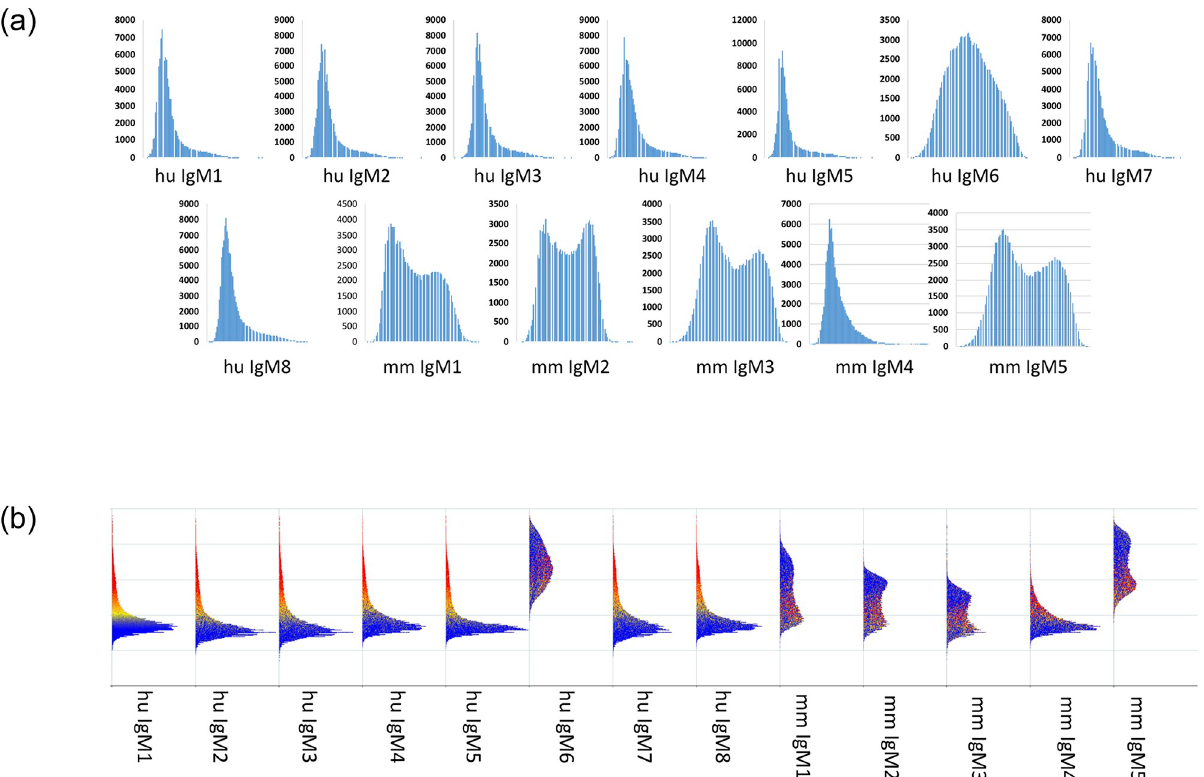
Fig 6. Data distribution for monoclonals shown in Fig 4. Data for all 125,000 peptides from CIM125K are shown as a density plot, either one by one (top plots) or side-by-side (bottom plot). For the distributions shown along the bottom, blue color indicates low intensity binding while yellow and red indicate higher binding at least above the median signal for that array. Antibodies are shown in the same order as Fig 4. Wide/broad distributions match promiscuous binding of specific antibodies, narrow distributions suggest more specific binding. No other serological test performed on any of these antibodies led investigators to predictions of efficacy, but therapeutic efficacy of these IgM antibodies correlated perfectly with the broad distributions and relatively high entropy scores.